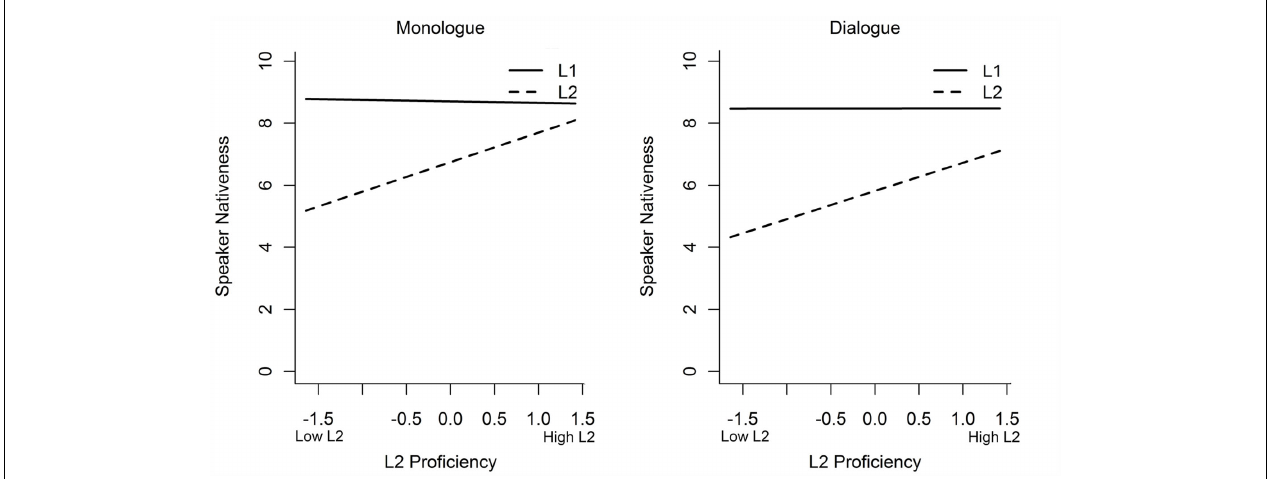
was lower in L2 vs. L1 in dialogues vs. monologues. Speaker nativeness was lowest in L2 vs. L1 for low L2 proficiency bilinguals but L2 vs. L1 difference decreased for high L2 proficient